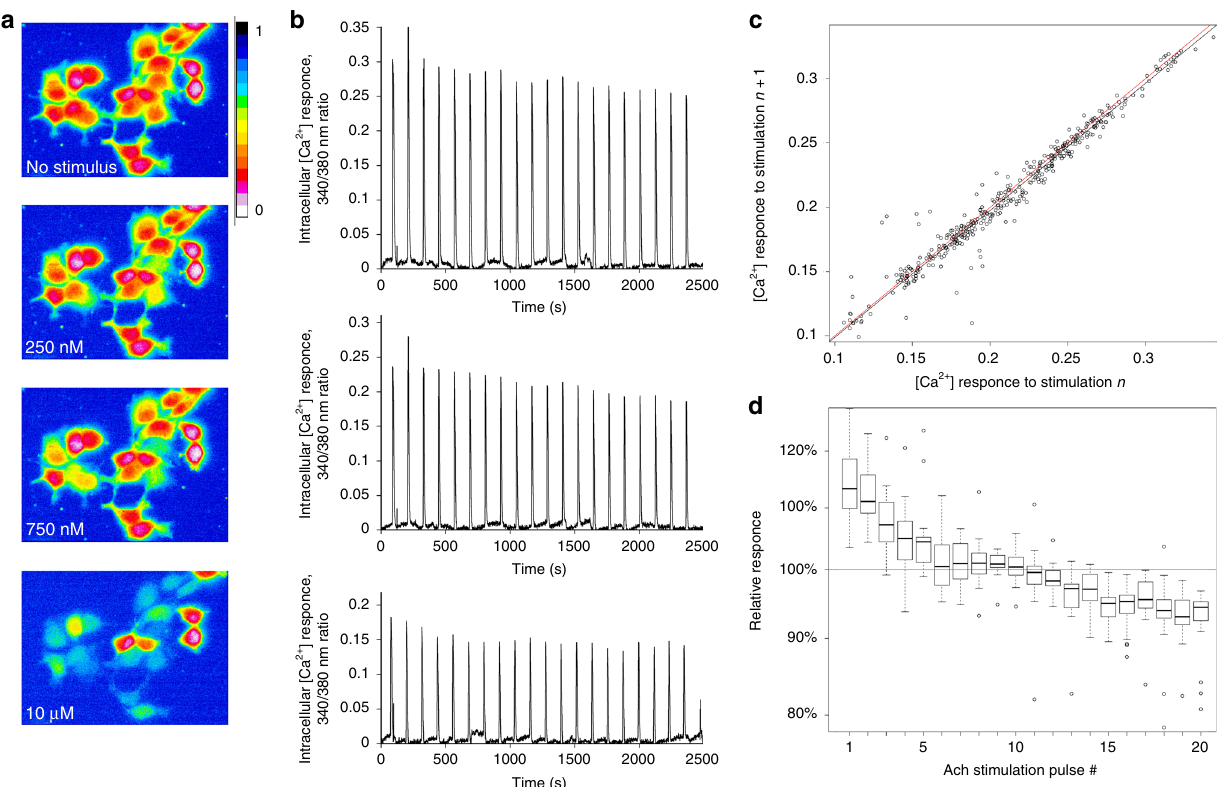
Fig. 2 Single-cell analysis of response to repeated stimulations. a Example of the experimental setup. A fi eld of HEK293 cells loaded with Fura-2 AM is microscopically captured and imaged after buffer only perfusion (no stimulus), or perfusion with 250nM, 750nM, and 10 µ M Ach. The intracellular Ca 2+ response is given as the 340/380 nm ratio in the pseudocolor (scale given to the right of the top panel). Cell stimulation is seen as the change in the cell color from red (ratio close to zero) to yellow or blue. The images given here are captured from Supplementary Movie 1. b Three examples of individual cell ’ s responses to repeated (×20) stimulations with 250 nM Ach. Well-responding cells are selected for clarity. It is apparent that: (i) different cells respond with different strengths to the same agonist concentration; (ii) the response strength of the same cell is reproducible over multiple stimulations; (iii) a slight trend of a decrease in the response strength is seen from early pulses to later pulses of stimulation. c Correlation analysis of the reproducibility in individual cell ’ s responses to repeated stimulations. Each circle represents a pair of consecutive response to the same stimulation in the same cell. The responses are highly conserved but tends to dampen as can be observed from the linear regression (black line), which has a slope signi fi cantly lower than one (red line shows the diagonal). d Cells adapt (desensitize) their Ca 2+ response over time, as repeated equal stimulations lead to a slight but signi fi cant dampening of the